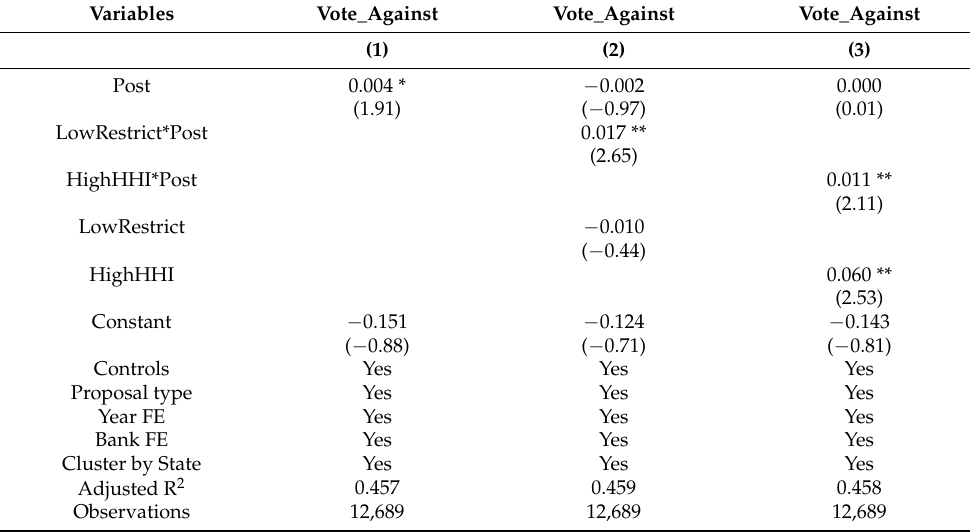
Table 9. Sample with only first instance of deregulation for each state.